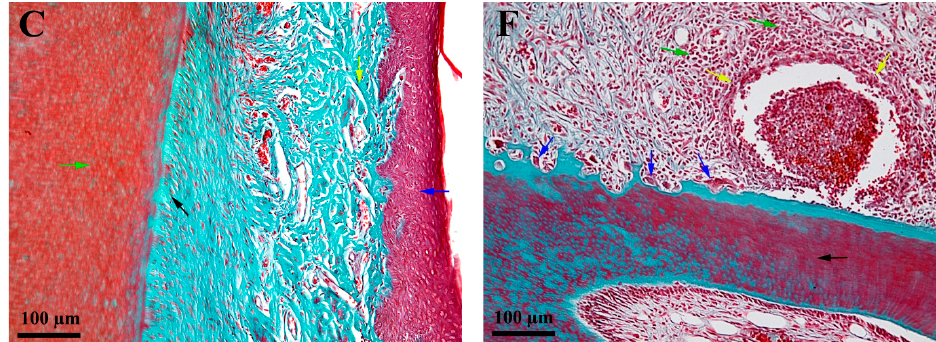
Figure 3. Histological aspects; A-C incisors; D-F molars; Goldner’s trichrome stain ( A )—black arrow—incisor crown; blue arrow—gingival tissue; green arrow—sulcus; red arrow—alveolar bone; yellow arrow—alveolar ligament; ( B )—green arrow—dentin; blue arrow—gum; yellow arrow—sulcus; red arrow—discreet congestion of small superficial vessels; black arrow—alveolar ligament; ( C )—green arrow—dentin; blue arrow—gingival epithelium; yellow arrow—lamina propria; black arrow—alveolar ligament; ( D )—black arrow—ligature thread; blue arrow—alveolar ligament necrosis; yellow arrow—interradicular necrosis; red arrow—alveolar bone; green arrow—gingiva; ( E )—black arrow—alveolar bone; blue arrow—osteoclast erosion of the alveolar bone; yellow arrow—inflammatory infiltrate; ( F )—black arrow—the root of the molar; blue arrow—osteoclast erosion of the root cementum; yellow arrow—incipient granuloma; green arrow—inflammatory infiltrate.